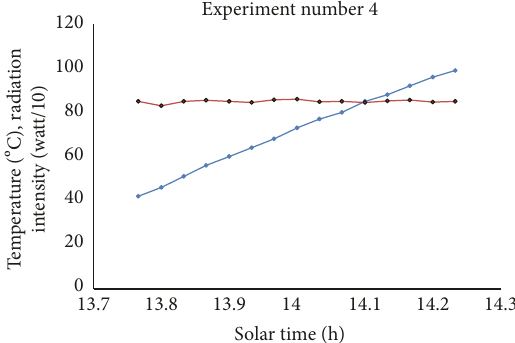
Figure 14: Plot of temperature (blue) and solar radiation intensity (red) versus time for the fi rst experiment with 850 gm of vegetable oil load. Radiation intensity is divided by 10 to fi t the scale.